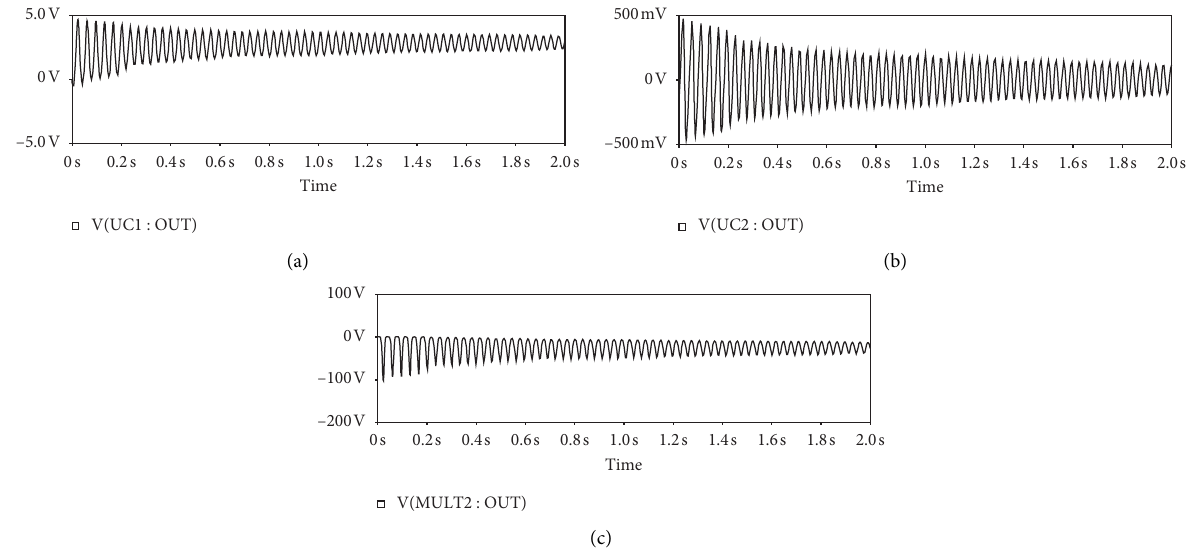
, (b) amplifier with capacitor C 1 � 12 V ,R � 5 K Ω ,R cc 4